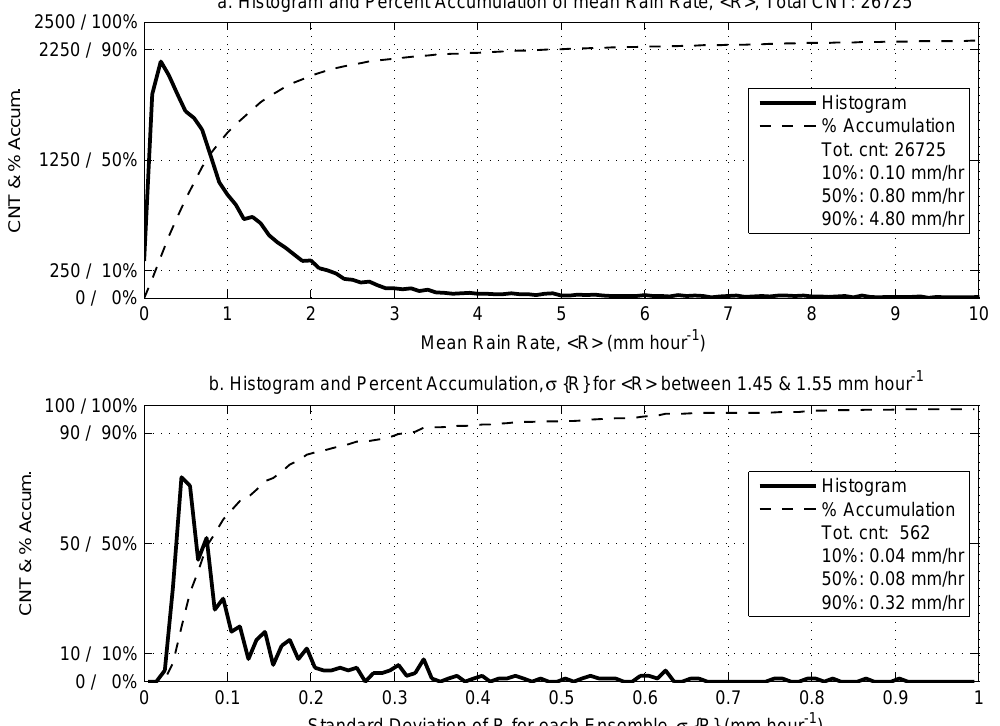
Fig. 7. Panel (a) shows the histogram of h R i occurrence for all 26725 ensembles as a function of retrieved h R i (solid line) and the percent accumulation from 0 to 100% (dashed line). Panel (b) shows the histogram of σ { R } for the small range of 1 . 45 < h R i < 1 . 55mmh − 1 . Panel (b) also shows the percent accumulation from 0 to 100% of these 562 ensembles in this sub-set. The values of the 10th, 50th, and 90th percentiles are indicated in the two